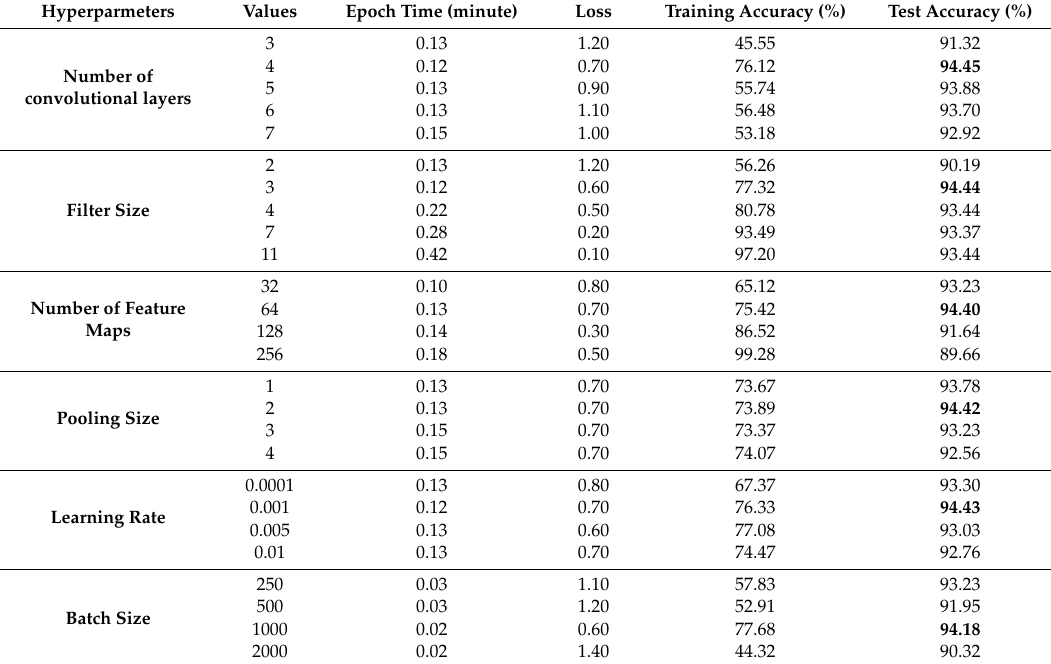
Table 4. Hyperparameter setting for Our CNN